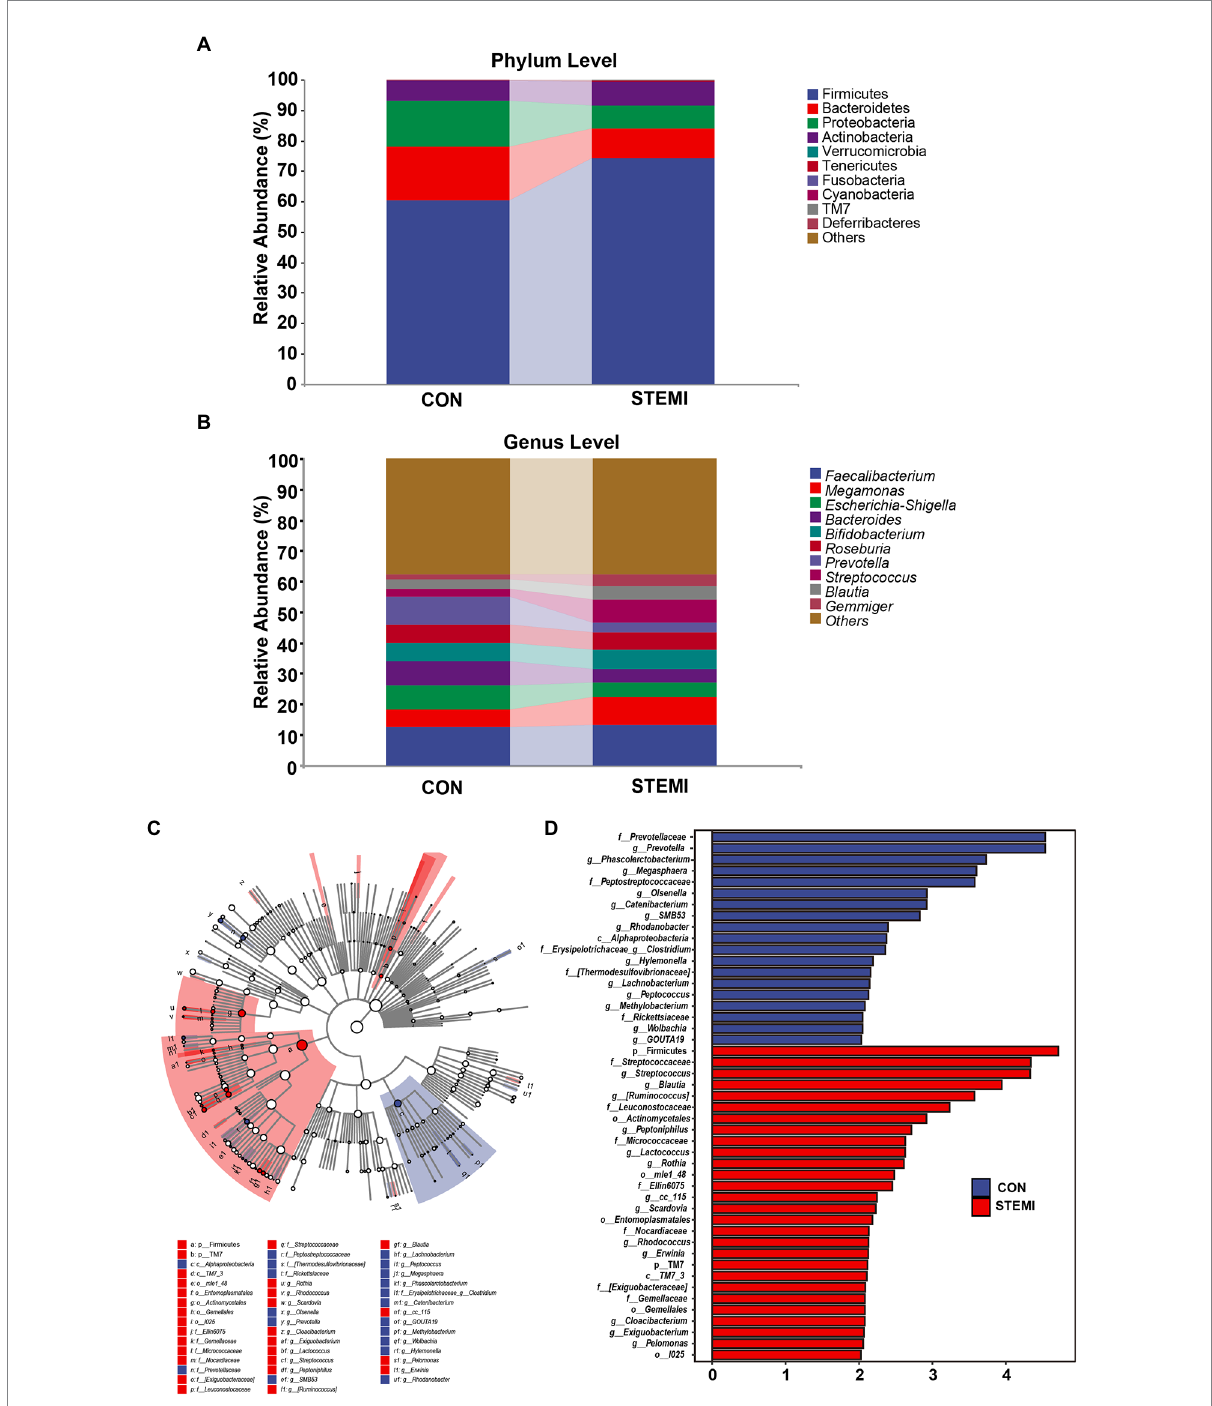
FIGURE 2 Taxonomic alterations in the patient and control groups. (A) Composition of gut microbiome communities at the phylum level. (B) Composition of gut microbiome communities at the genus level. (C) Cladogram and (D) Histogram of the linear discriminant analysis effect size (LEfSe) method (LDA > 2, p < 0.05) for differentially abundant gut microbiome between the two groups. Blue and red colors represent gut microbiome that were significantly overrepresented in the control groups and STEMI patients,